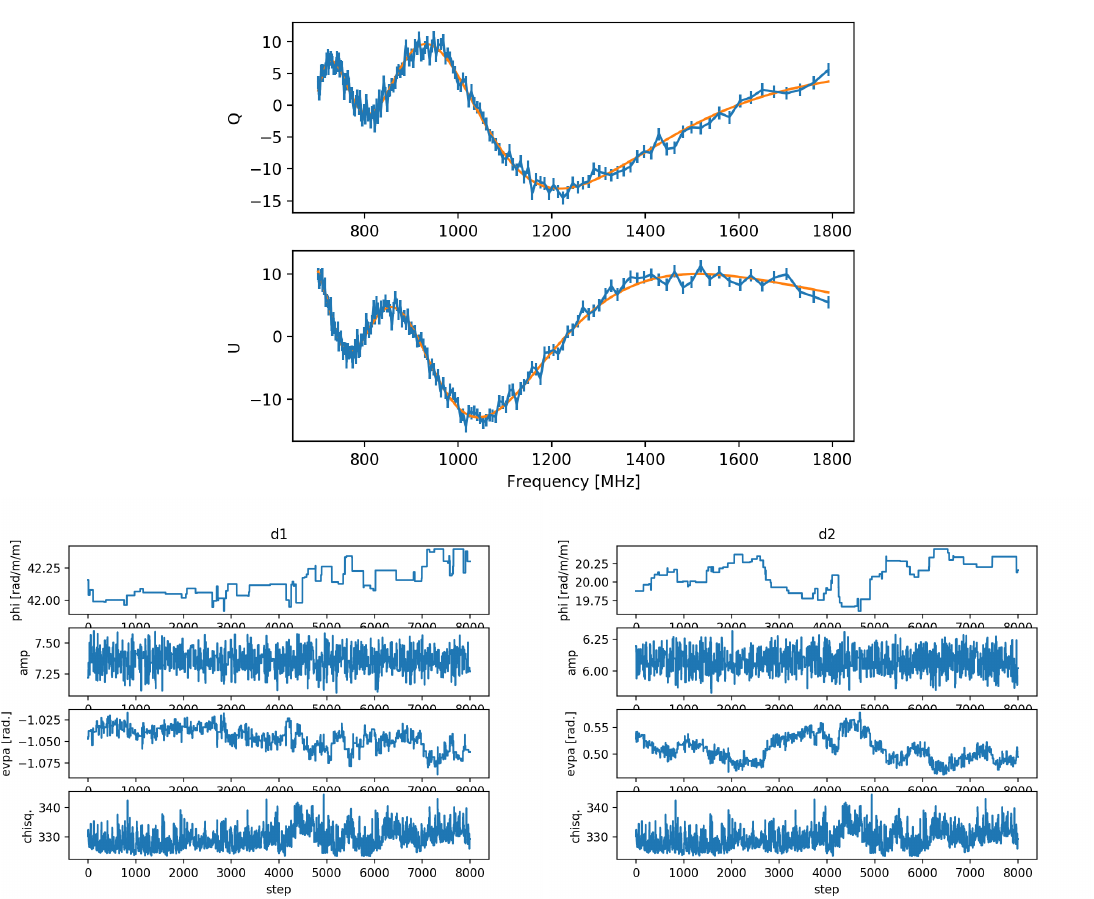
Figure 4. An example of the result of the QU-fitting. The figure shows the result when two delta functions are adopted in the fitting model, applied to mock data produced using the model d 2 with the frequency band case I. The top panel shows the Stokes Q and U spectra of the mock data (blue) and the fitted results (orange) in frequency space. The bottom left and right panels show the parameter chains for the first and second components of the fitting model and χ 2